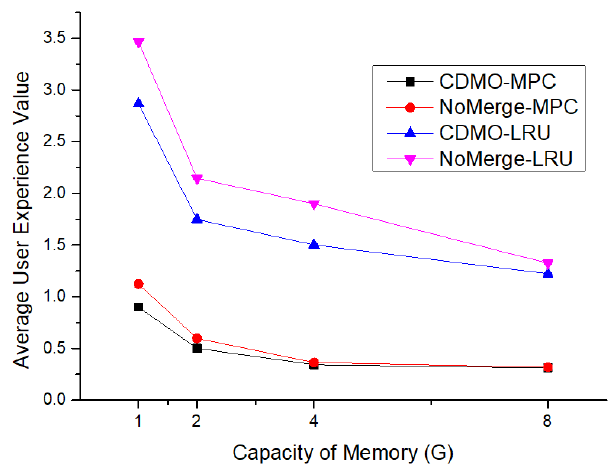
Fig. 6 The performance of the merging algorithm. LRU, least recently used; LFU, least frequently used.